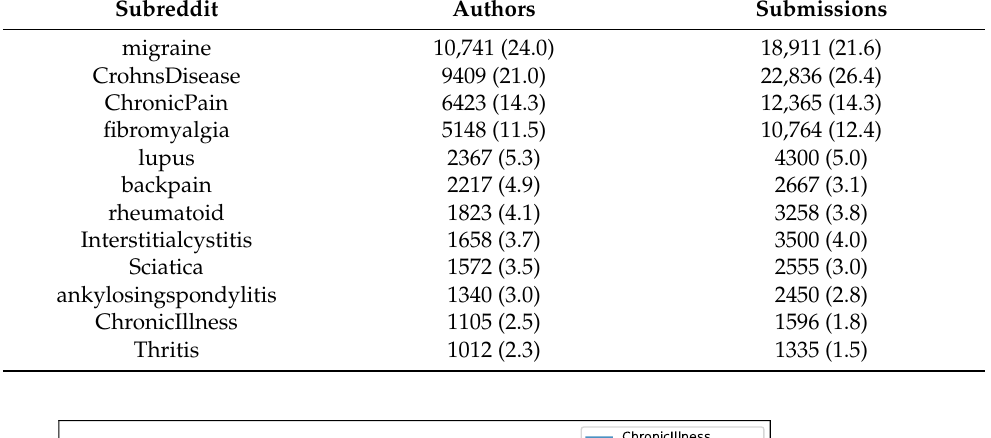
Table A1. Number of authors and submissions per subreddit. Percentage in relation to the whole dataset is shown in parentheses.